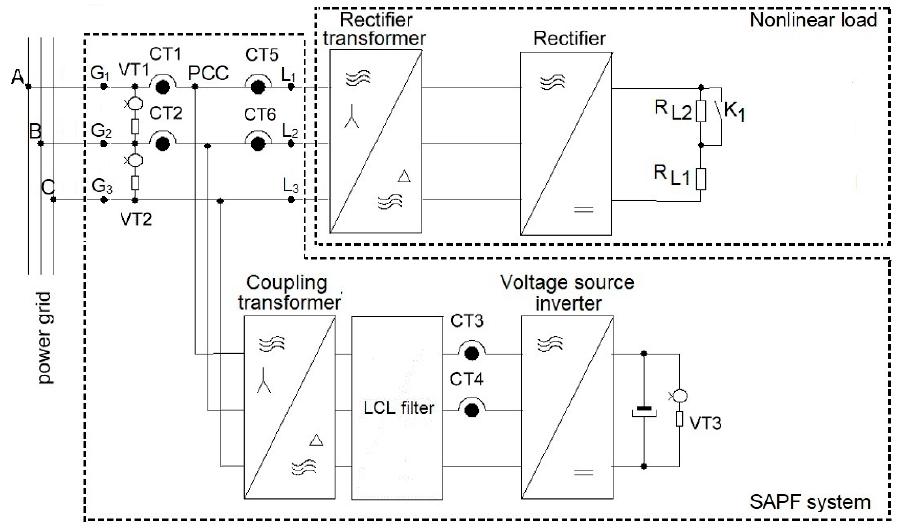
Figure 16. Block diagram of the experimental setup including the transducers system.